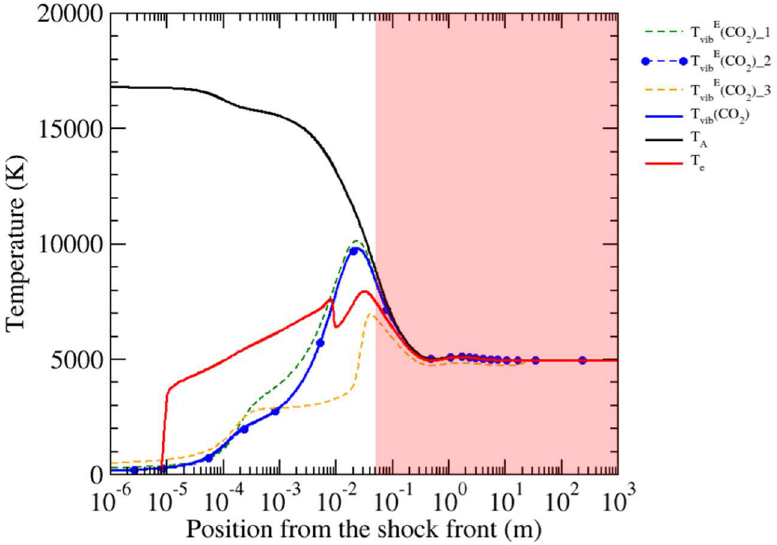
Figure 5. Distribution of the electron temperature T e , the heavy particle temperature T A , and the post-processed energy-dependent vibrational temperature of CO 2 for the first (symmetric stretching) mode, second (bending) mode and third (asymmetric stretching) mode. The total energy-dependent vibrational temperature is also displayed. The limit of the boundary layer is located at δ ≈ 5 cm: in the red region, feature of the flow in case of infinite shock layer thickness.